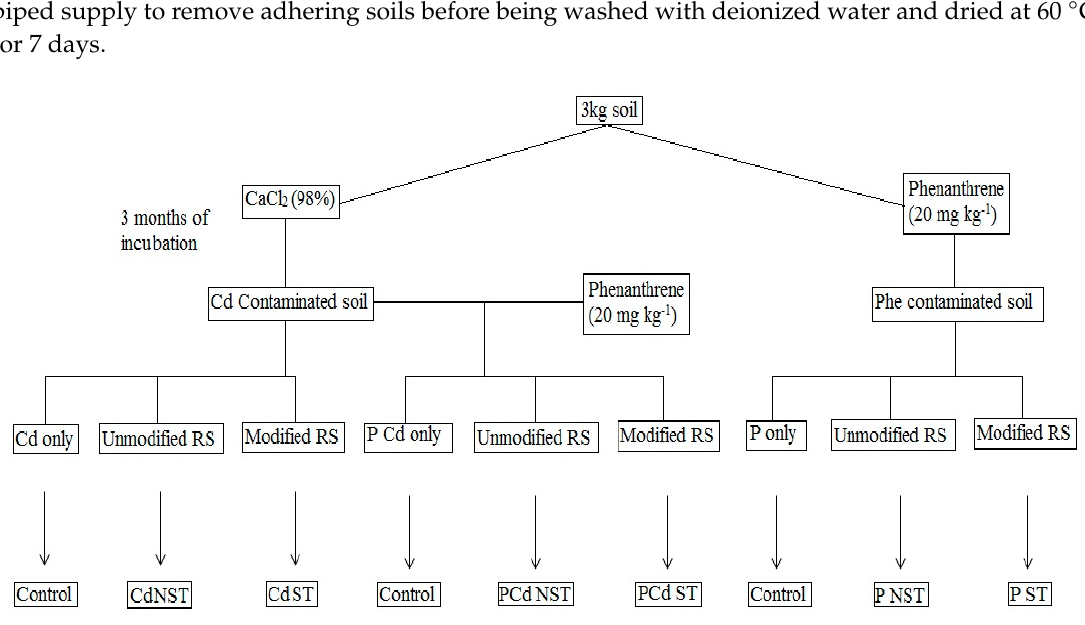
Figure 9. Summary of experimental design with all different treatments.